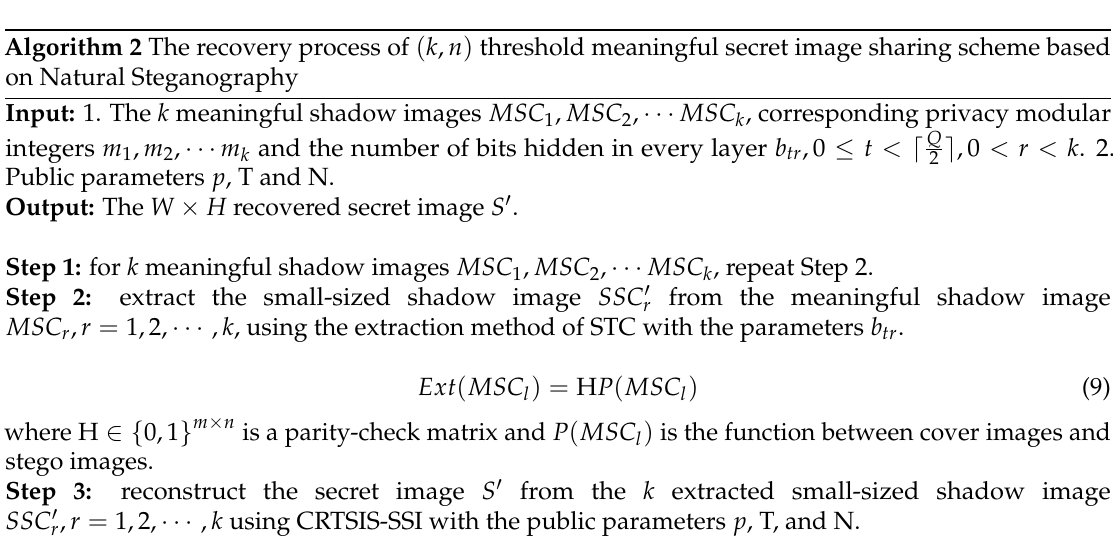
Algorithm 2 The recovery process of ( k , n ) threshold meaningful secret image sharing scheme based on Natural